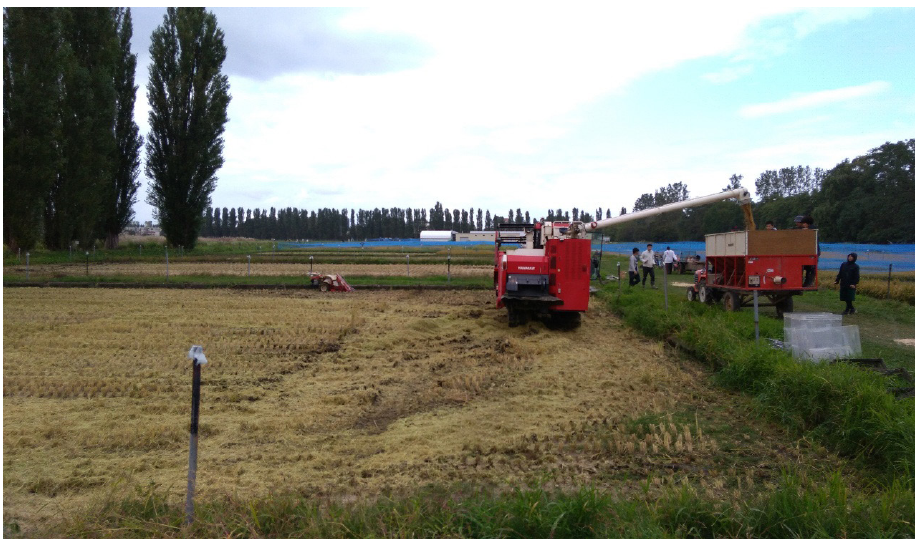
Fig. A2 Weeds were sampled around the “natural farming” rice paddy located in the Field